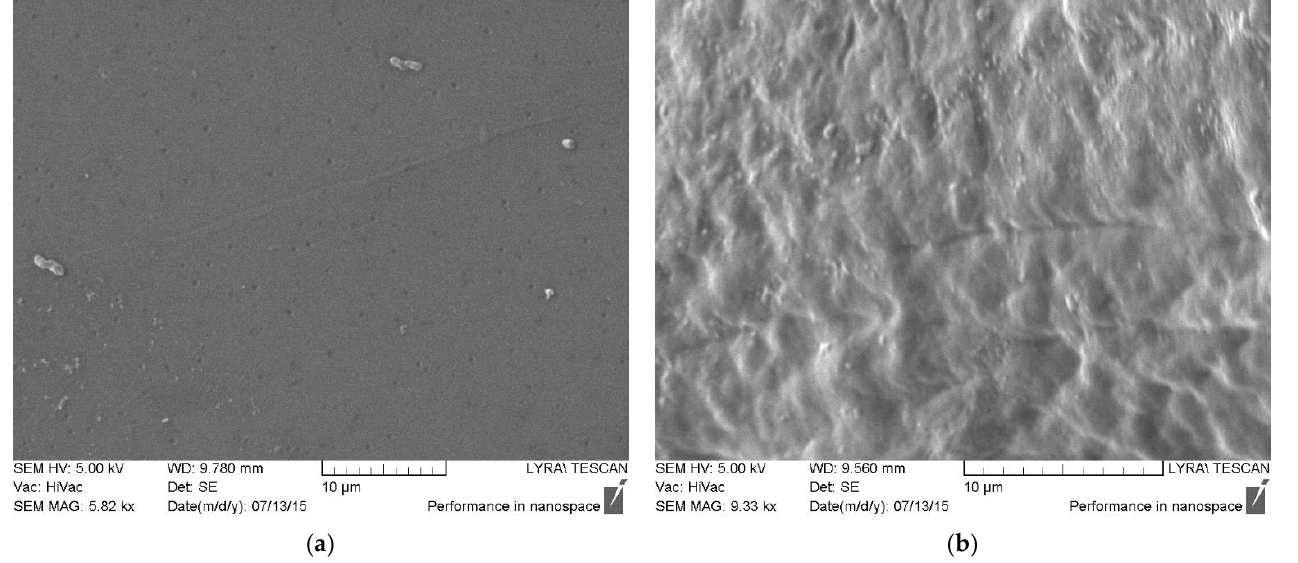
Figure 5. SEM images of PLA substrate ( a ), and drug-free multilayer film MLF-PL ( b ).